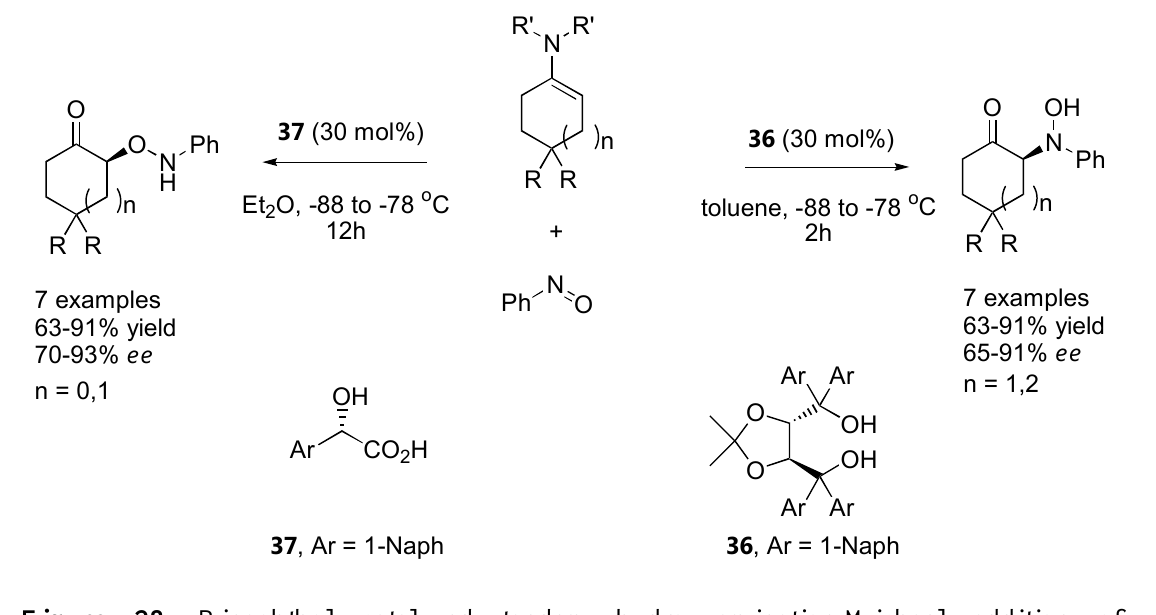
Figure 28. Binaphthol catalyzed tandem hydroxyamination-Michael addition of cyclohexenone enamine [94].